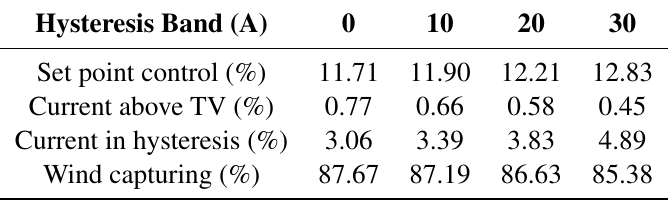
Table 8. Simulation results: controlled relief of the control action and the effect of the hysteresis